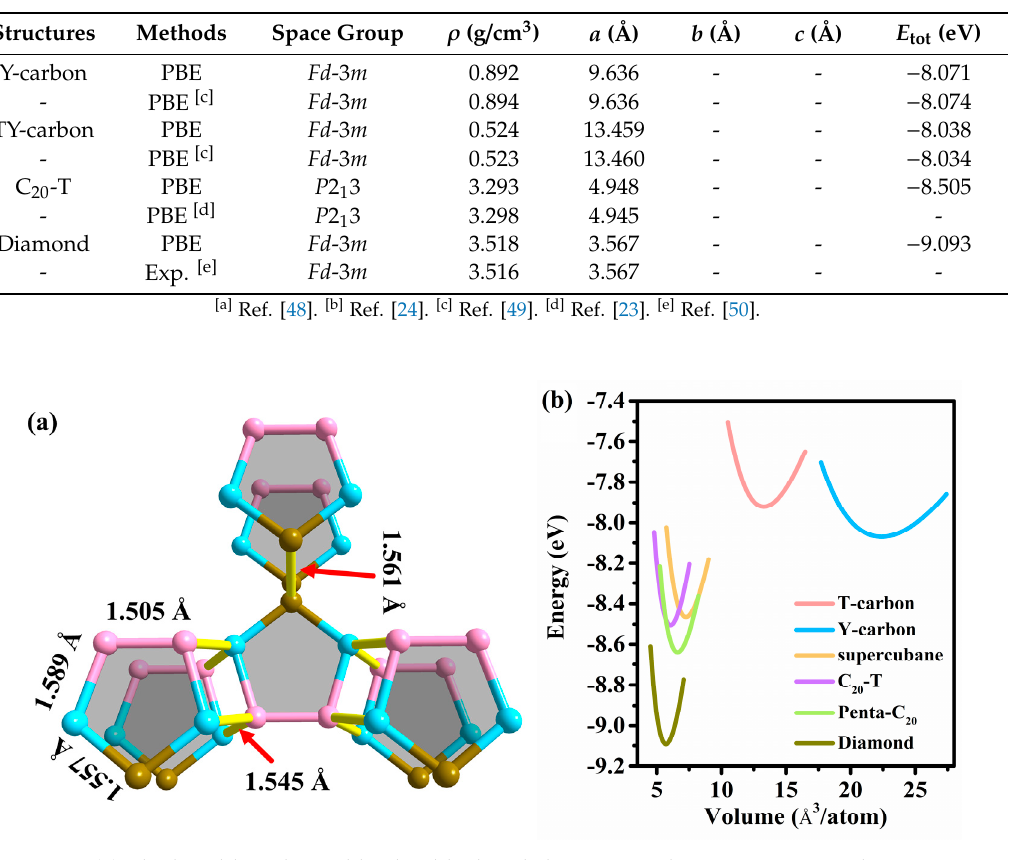
Figure 2. ( a ) The bond lengths and bridge-like bonds between carbon pentagons in the Penta-C 20 structure. The bridge-like bonds are represented as bright yellow sticks. ( b ) The total energy vs the volume per atom for Penta-C 20 in comparison with several other previous carbon allotropes.